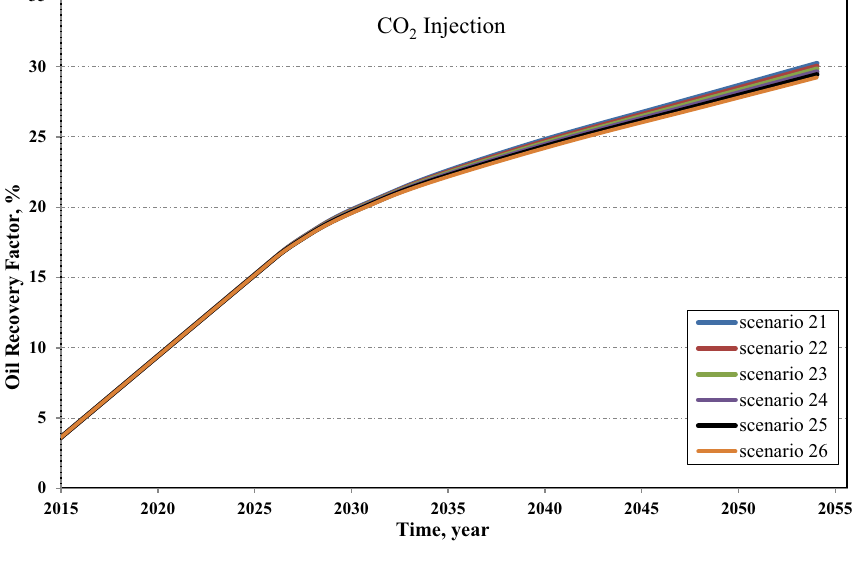
Fig. 9 Oil recovery factor for CO 2 injection into different reservoir